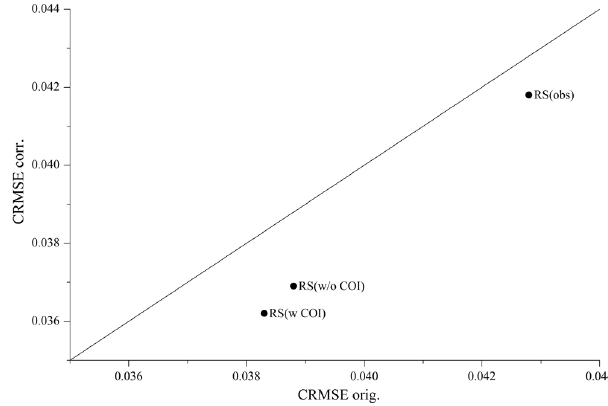
Fig. 14. CRMSE of corrected vs. original d D/ d t COI